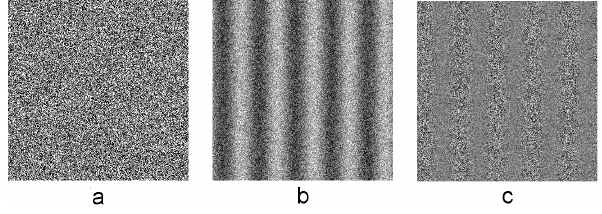
Figure 2. Average contrast sensitivity for the identification of the direction of first-order motion for amblyopic eyes (AE, Circles), non-amblyopic eyes (NAE, Squares), and control eyes (CE, Triangles). Error bars represent one standard error of the mean.